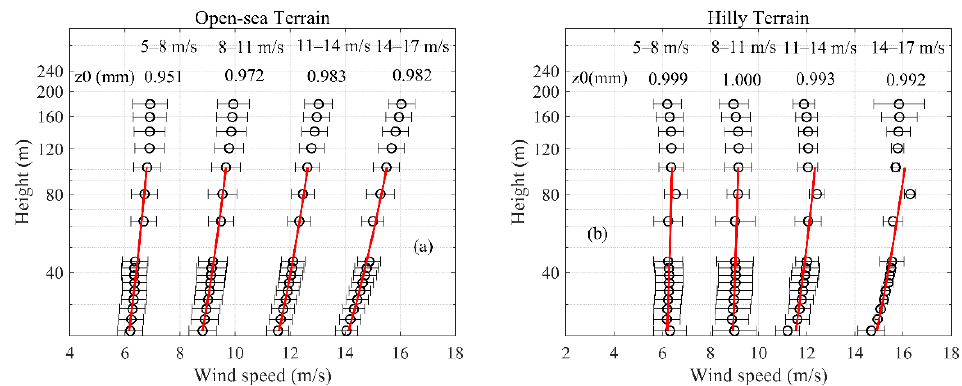
Figure 5. Composite vertical profiles of mean wind speed under different upstream terrain conditions. The circle represents the composited mean wind speed, and the error bar represents the standard deviation. The red solid line represents log-law fit of mean wind speed up to 120 m. ( a ) for open-sea terrain, i.e., 60° to 240° ( b ) for hilly terrain, i.e., 0° to 50° and 290° to 360°.